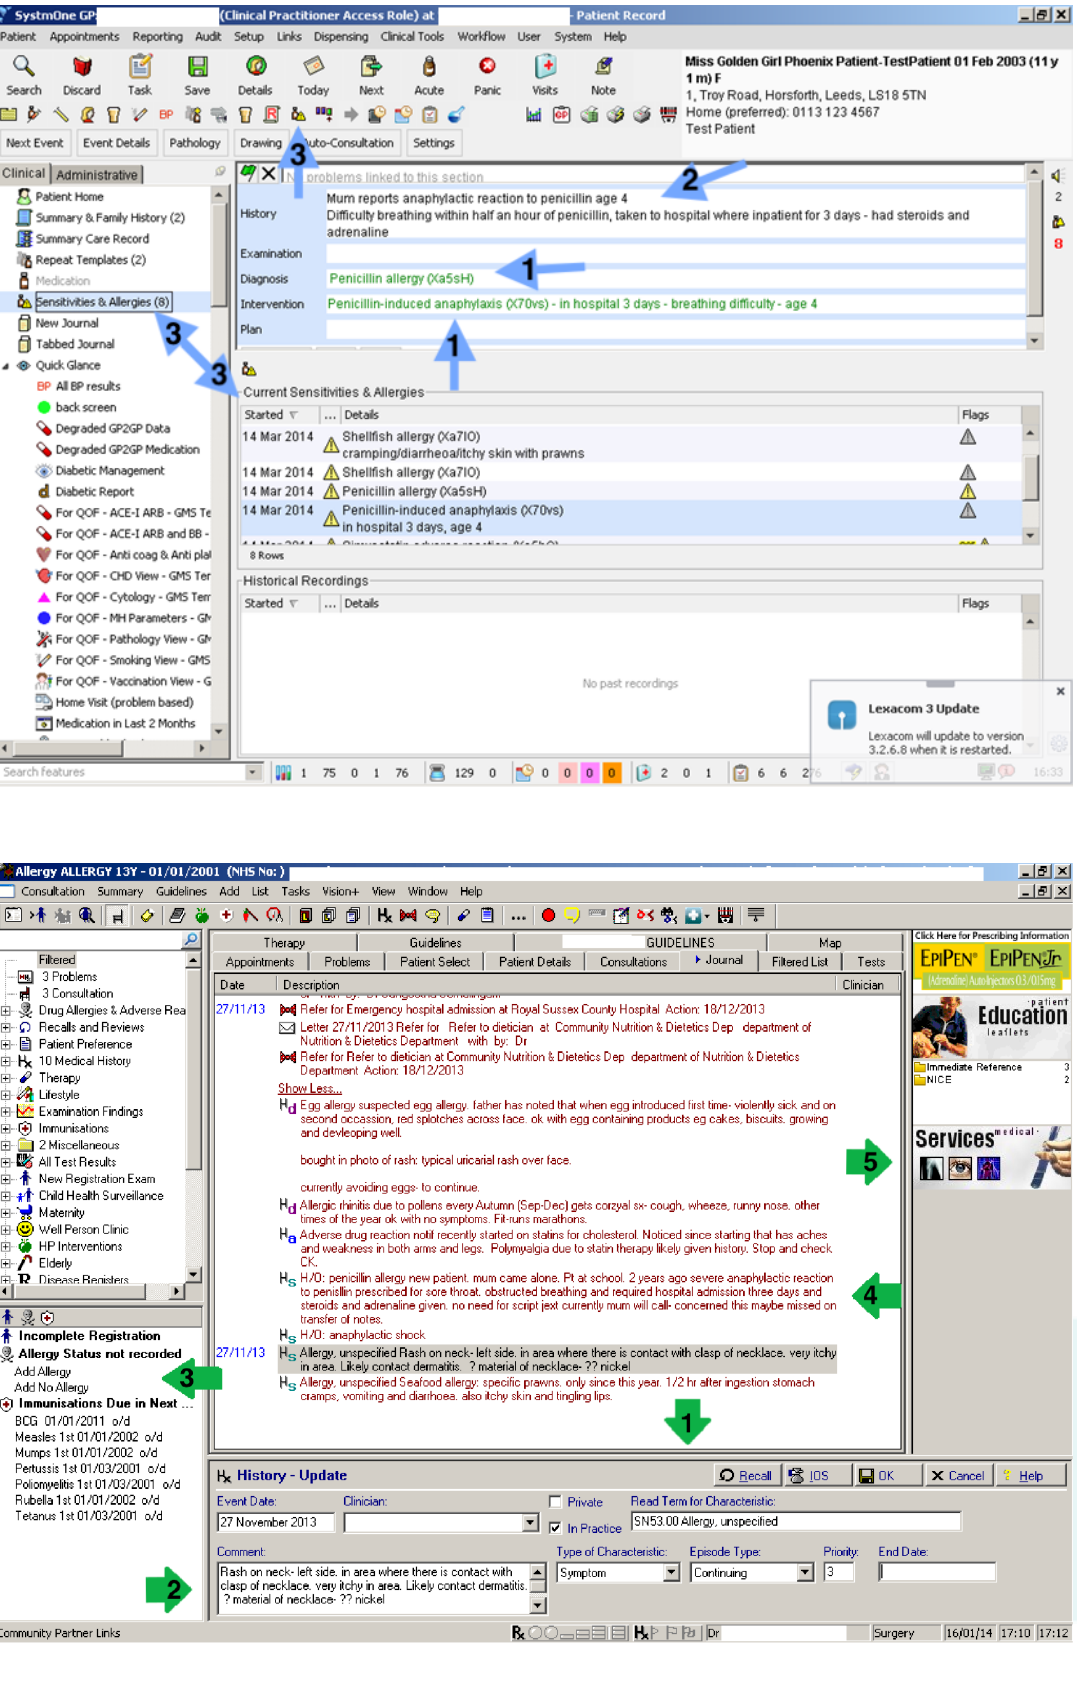
Figure 3: Example screen prints from SystmOne (top) and Vision (bottom). 1 = Read code entry, 2 = Free text entry, 3 = Allergy entry feature, 4 = Combined Read code and free text, 5 = EHR features (patient and professional information